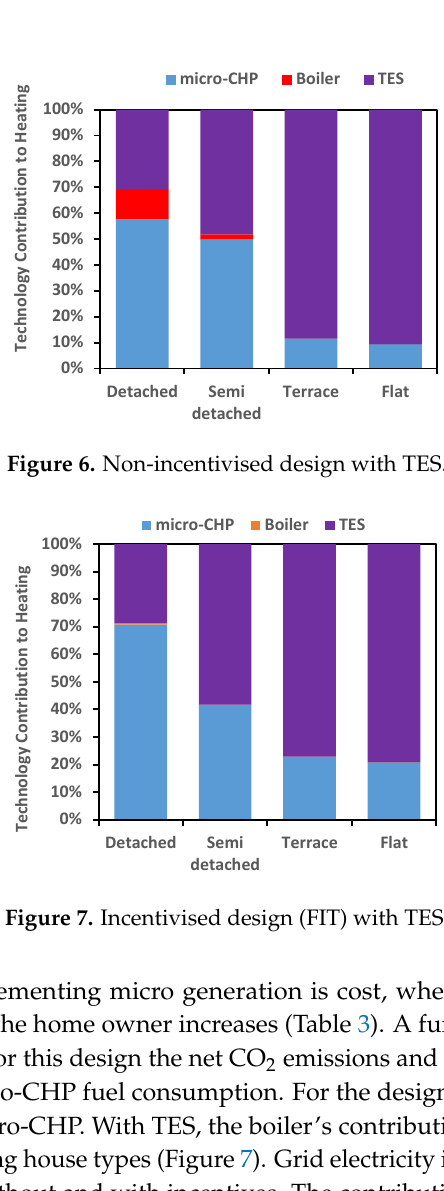
Table 2. Non-incentivised design results.